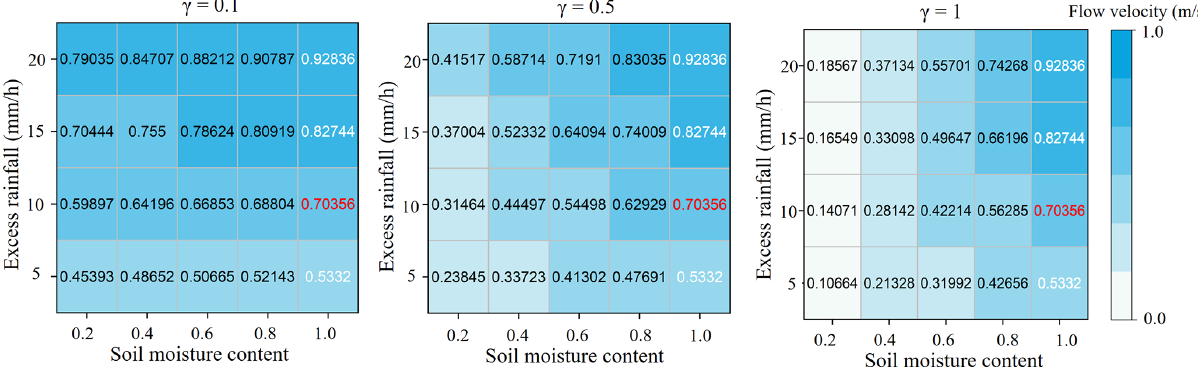
= 0 . 5. (b) I t = 1. I c I c